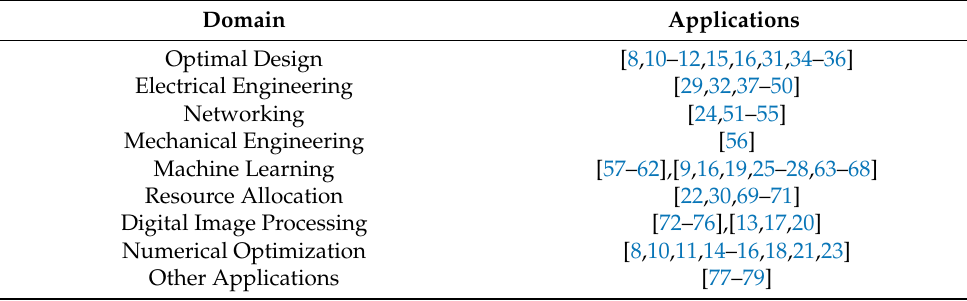
Table 6. Applications of DA and its hybrids in different